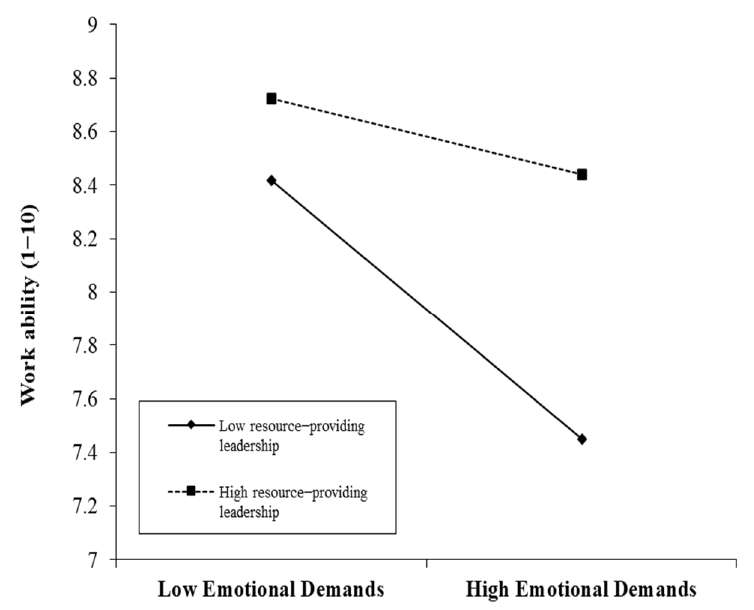
Figure 2. Prediction of work ability by emotional demands (Level 1 and group − mean centered) as a function of resource − providing leadership (Level 2).